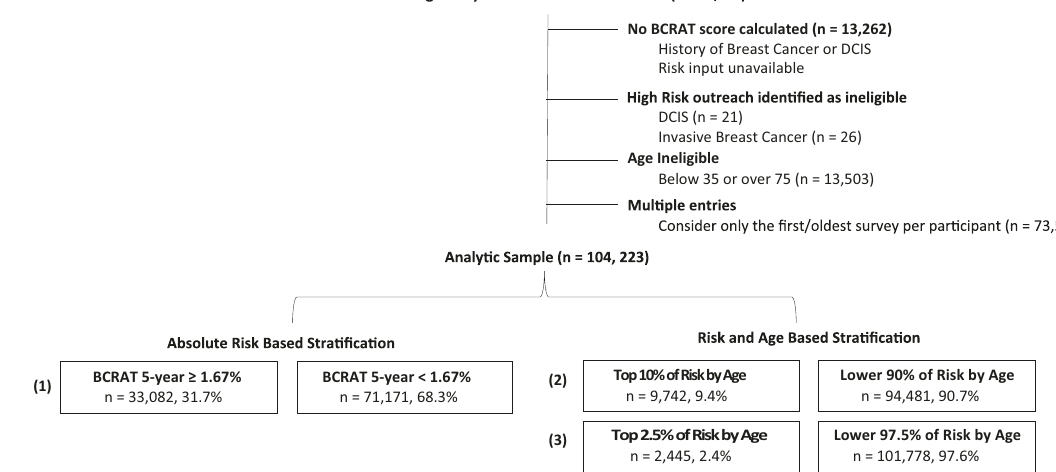
Fig. 1 Consort diagram: Athena Breast Health Network breast screening registry. The inclusion and exclusion criteria for the analytic sample in Athena Network registry. (1) refers to threshold 1: FDA approval for tamoxifen and raloxifene is 5-year risk score > 1.67; (2) refers to threshold 2: Use of Top 10% of Risk by Age; (3) refers to threshold 3: Use of Top 2.5% of Risk by